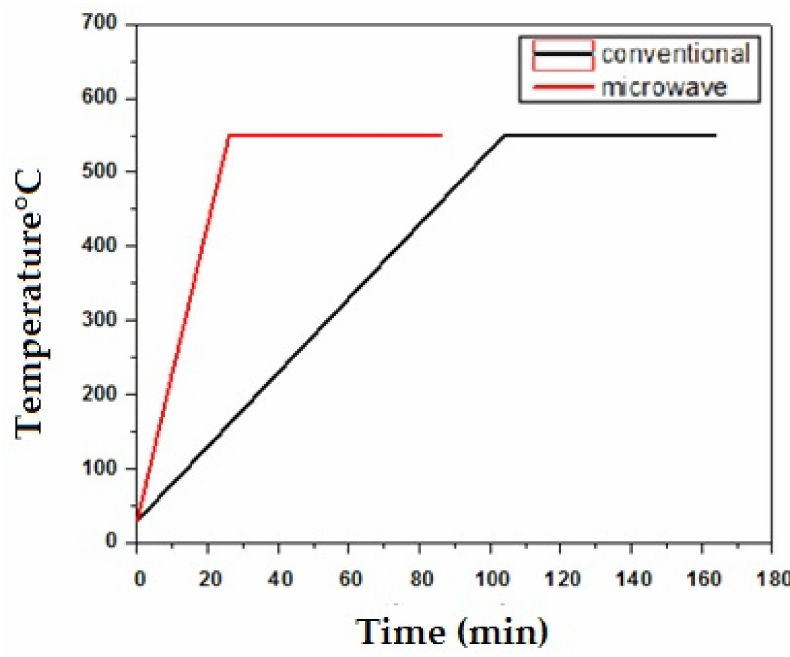
Figure 1. Heating profile of conventional sintering and microwave